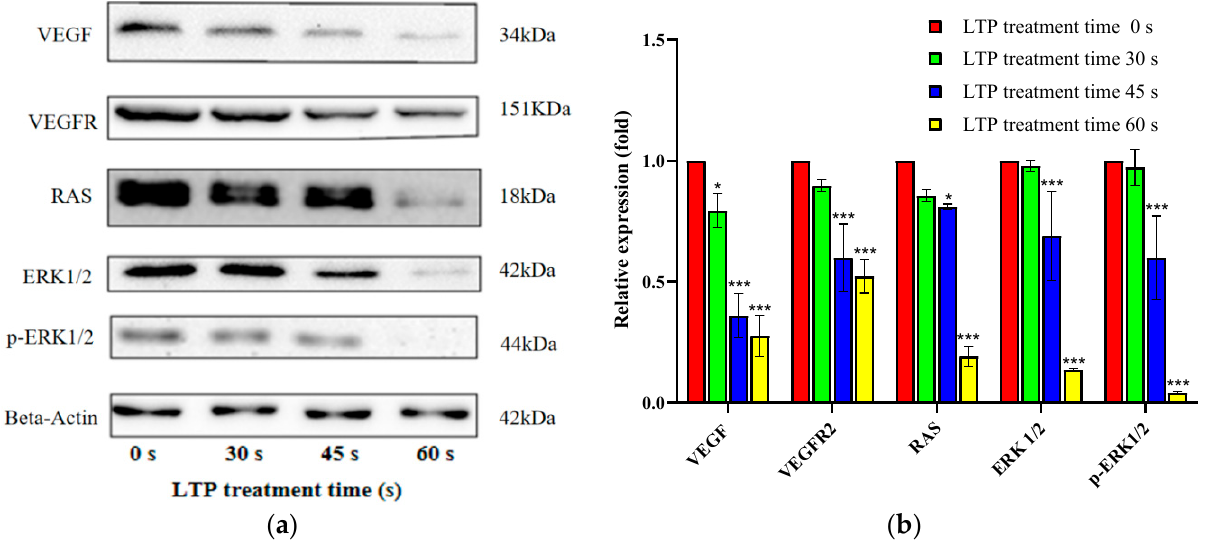
Figure 7. LTP induced CALU-1 cell death via VEGF/VEGFR2/RAS/ERK axis. ( a ) The expressions of key proteins in this signaling pathway were assessed by Western Blot analysis, ( b ) the data were quantitated and graphed. Data represent the means ± SD of three independent experiments, compared with 0 s LTP treatment time group. * p < 0.05; *** p < 0.001; compared with the 0 s LTP treatment group.